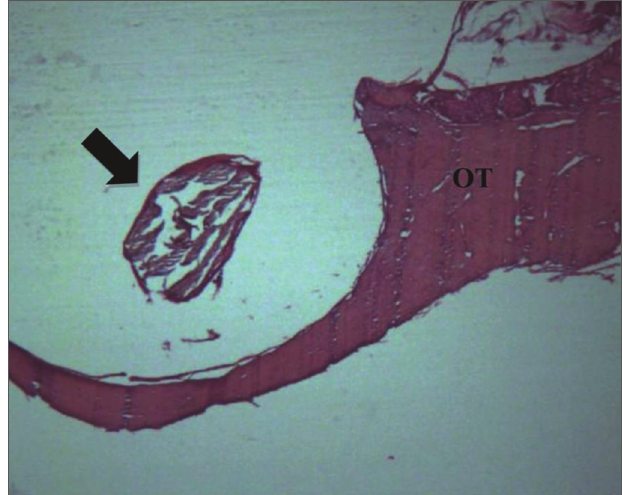
Figura 4. Grupo experimental reação crônica - Fotomicrografia de um fragmento da membrana do biopolímero da cana-de-açúcar sendo englobado por células gigantes tipo corpo estranho. BP= biopolí- mero da cana-de-açúcar. LB= luz da bula. Seta fina=célula gigante. HE(aumento de 1000x).